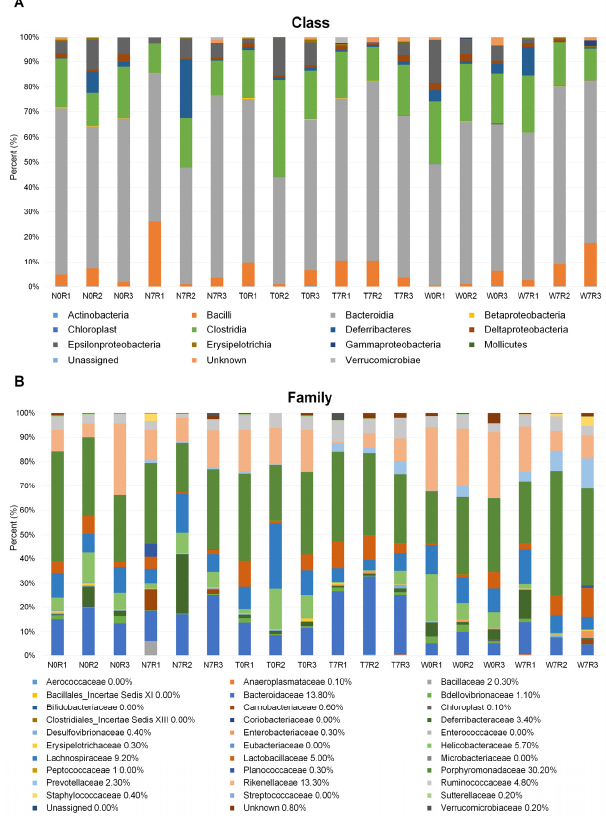
Figure 3. Taxonomical classification of OTUs in 18 samples. The identified OTUs were classified according to class (A) and family (B). Each color bar indicates the relative proportion of identified bacteria.